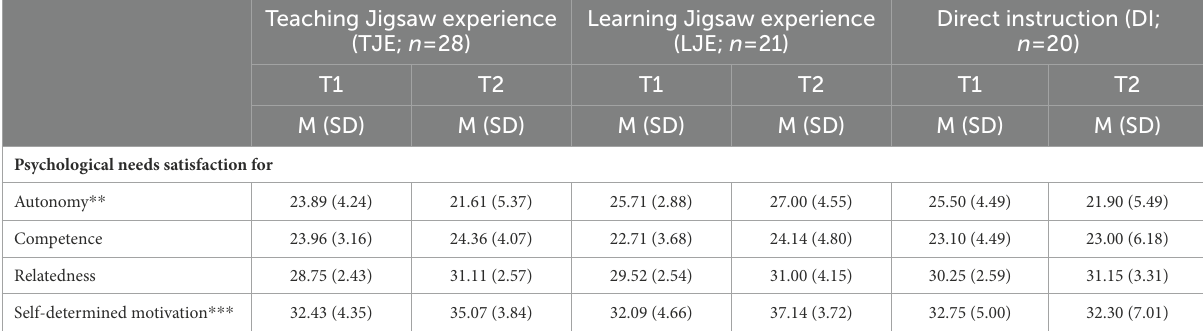
TABLE 2 Means (and standard deviations) for psychological needs satisfaction, and intrinsic motivation, by training type conditions and time ( N = 69). Teaching Jigsaw experience (TJE; n = 28)